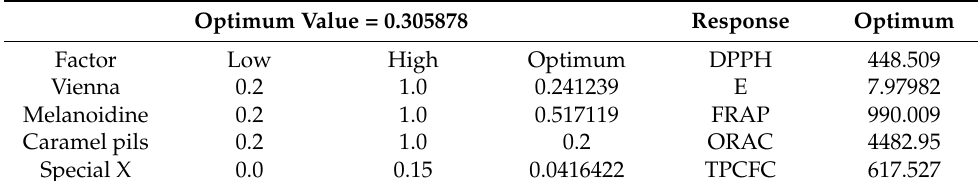
Table 5. Optimum desired values for Variant 5.